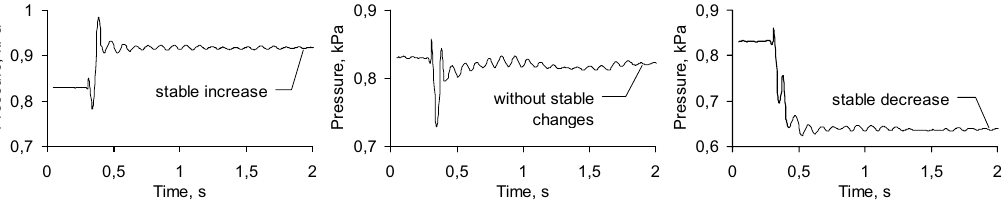
Fig. 6. Time histories of pressures for series 80S.